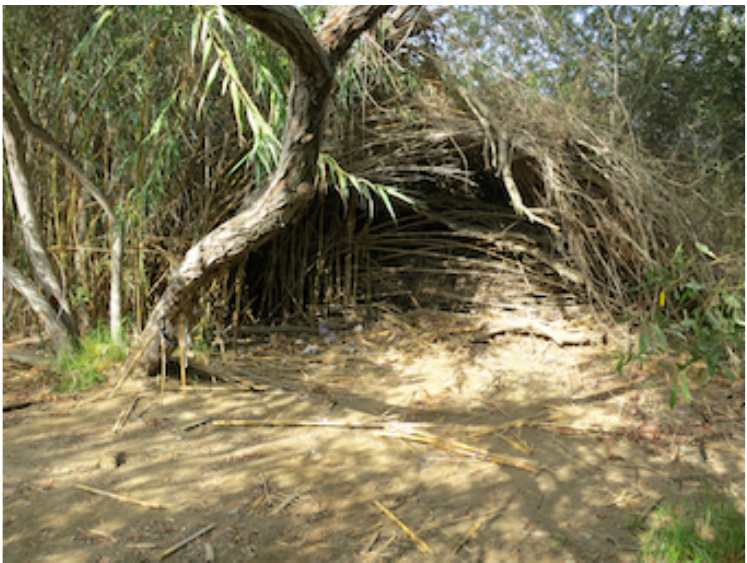
Figure 2. The location of Virginia’s camp (after it was cleared by the restoration